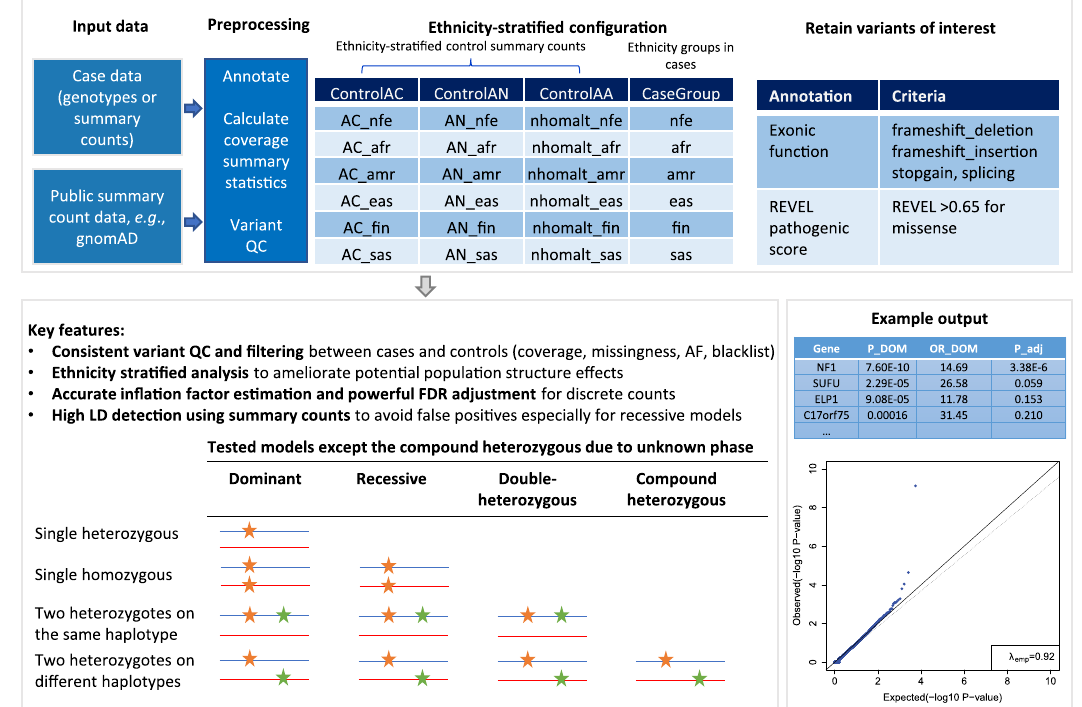
Fig. 1 Overview of the proposed framework CoCoRV. The top box describes the main input and preprocessing. The bottom left box describes the key features and the tested models. The bottom right box shows the main output. ControlAC: the annotation for the alternate allele count; ControlAN: the annotation for the total allele count; ControlAA: the annotation for the homozygous alternate genotype count; P_DOM: the raw P value of the dominant model using two-sided Fisher ’ s exact test, OR_DOM: the odds ratio of the dominant model; P_adj: the adjusted P values for multiple